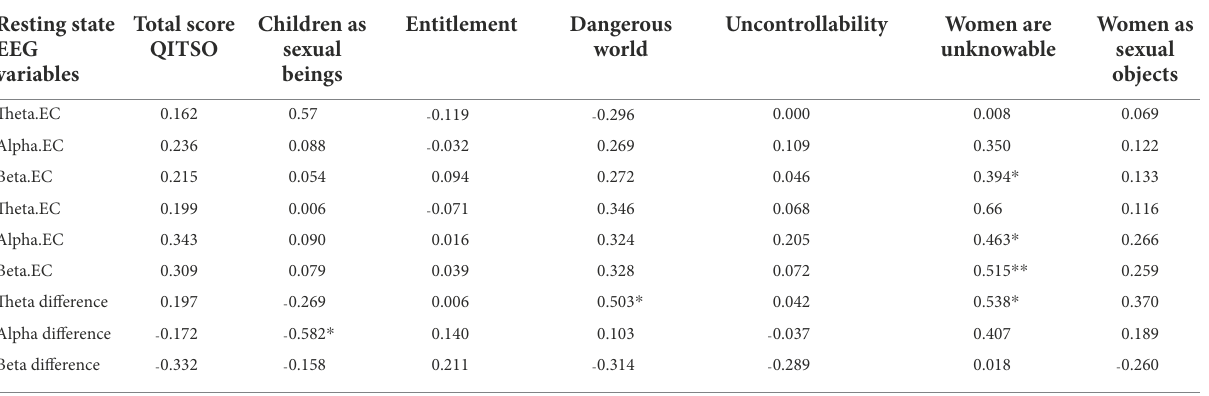
TABLE 6 Correlations between the QITSO and the resting state EEG data.